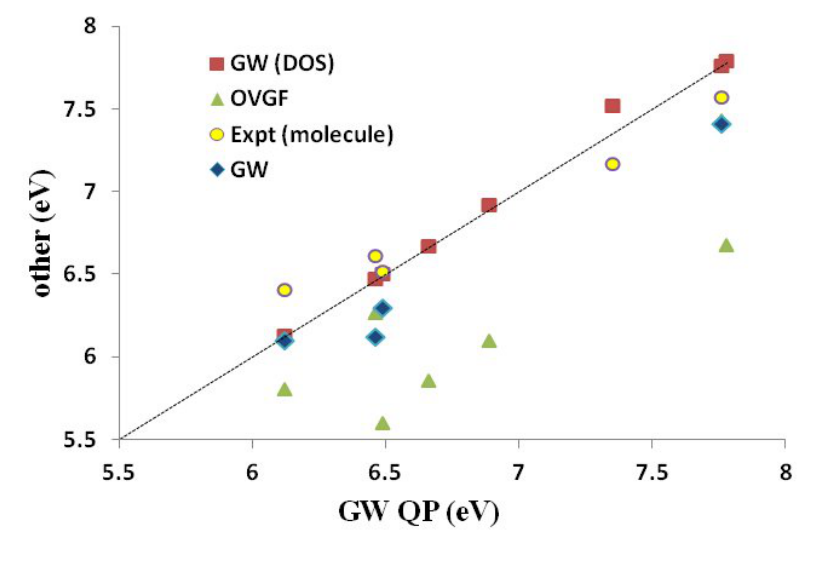
Figure 7. Correlation graph of data from Table 5 showing how experimental and Green’s function IPs compare. The label “ GW ” (as opposed to GW DOS and GW QP) is the calculated values taken from the literature (see Table 5). Units are in eV. The x -axis corresponds to our GW QP